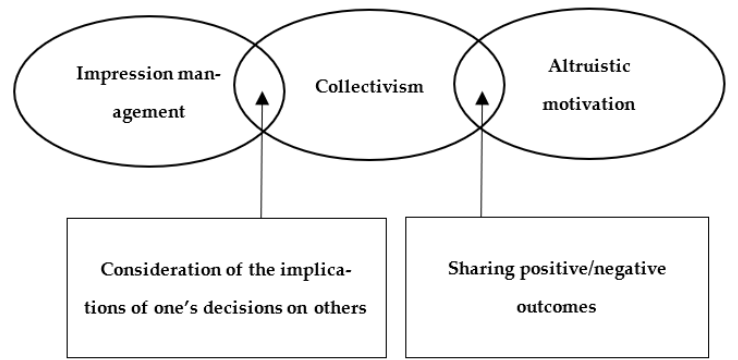
Figure 1. A conceptual model of this study